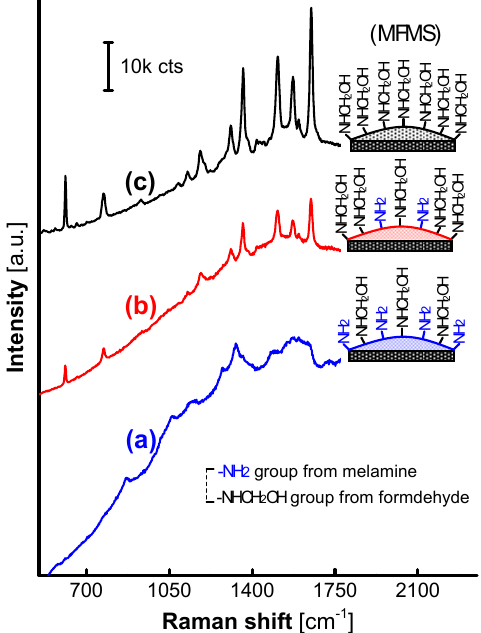
Figure 7. SERS spectra from R6G on AgNPs loaded on MF 3 synthesized in a set of reaction time. ( a ) 20 min; ( b ) 3 h; and ( c ) 8 h.